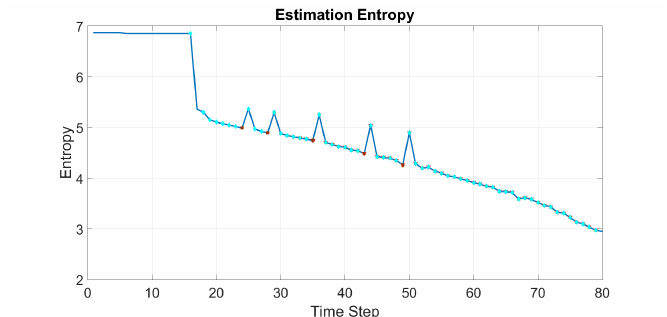
Figure 10. Variation of the entropy for the estimated probability distribution estimated by 100 weighted Gaussian functions. This entropy is related to the probability distribution estimated with one of the robots. The sensor detection with the robot is indicated with cyan diamonds, and the positive sensory events reported with other members of the team and contributed to the estimation is indicated with brown circles. As it can be seen these extra informations first disturbs the decreasing proceeding of the entropy of the estimation. However, eventually get in line with the general estimation of the